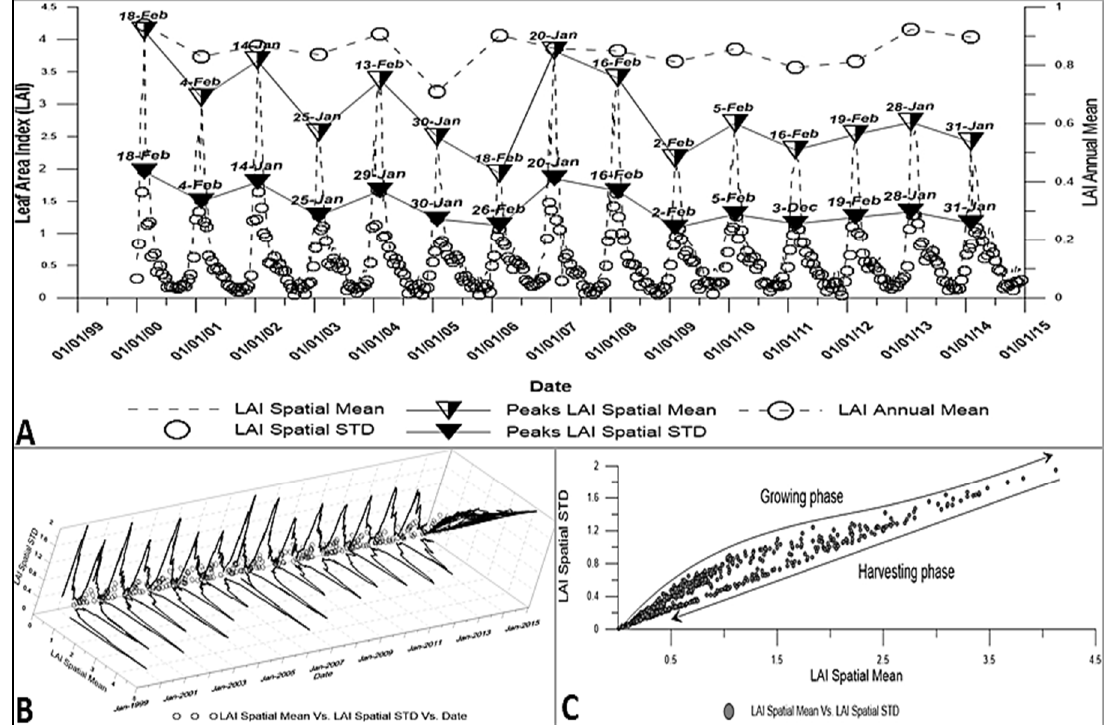
Figure 6. LAI Spatial Mean, Annual Mean and Spatial STD variation for the period 2000–2014 ( A ). 3D LAI Spatial Mean and STD combined plot with projection ( B ). Projection of the LAI Spatial Mean and LAI Spatial STD combined plot ( C ).